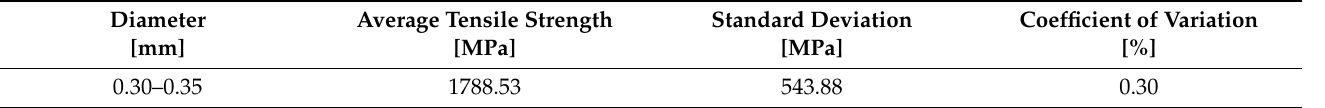
Table 2. Tensile strength of steel cord.